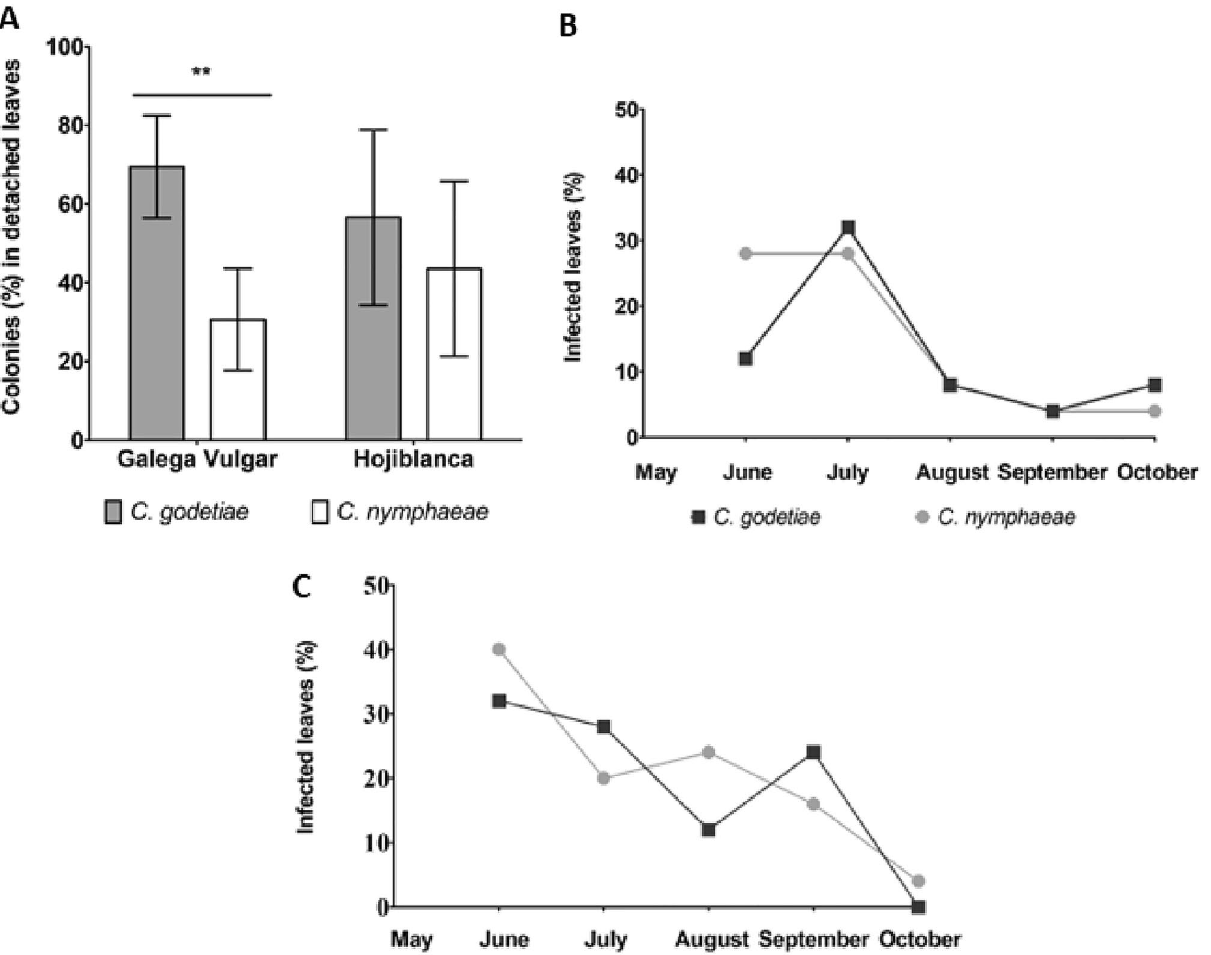
Figure 3. ( A ) Relative percentage of colonies of Colletotrichum godetiae and C. nymphaeae recovered from detached leaves of cultivars Galega Vulgar and Hojiblanca co-inoculated with both isolates. Percentage of olive leaves cv. Arbequina, which were co-inoculated ( B ) or independently inoculated ( C ) with both Colletotrichum species, the pathogens of which were recovered. *Significance between relative percentages according to the Chi-Square test.